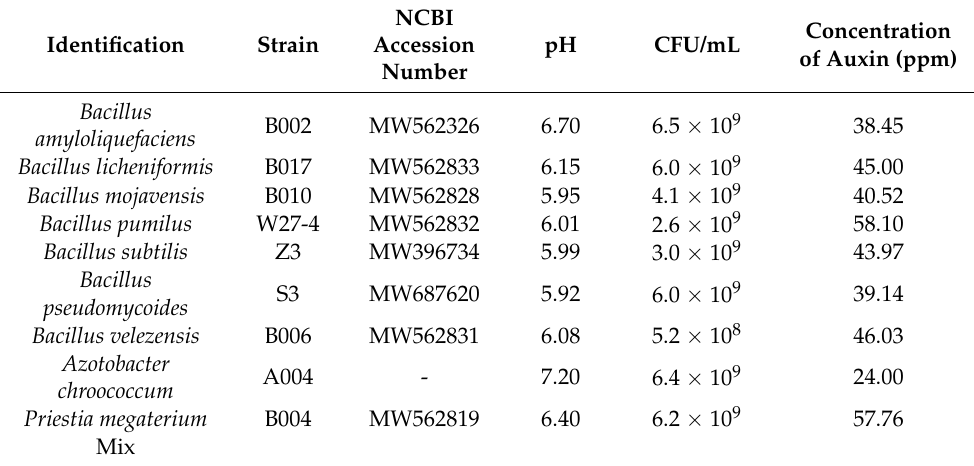
Table 1. Description of strain, NCBI accession number, pH, colony forming unit (CFU), and auxin concentration of PGPB used.